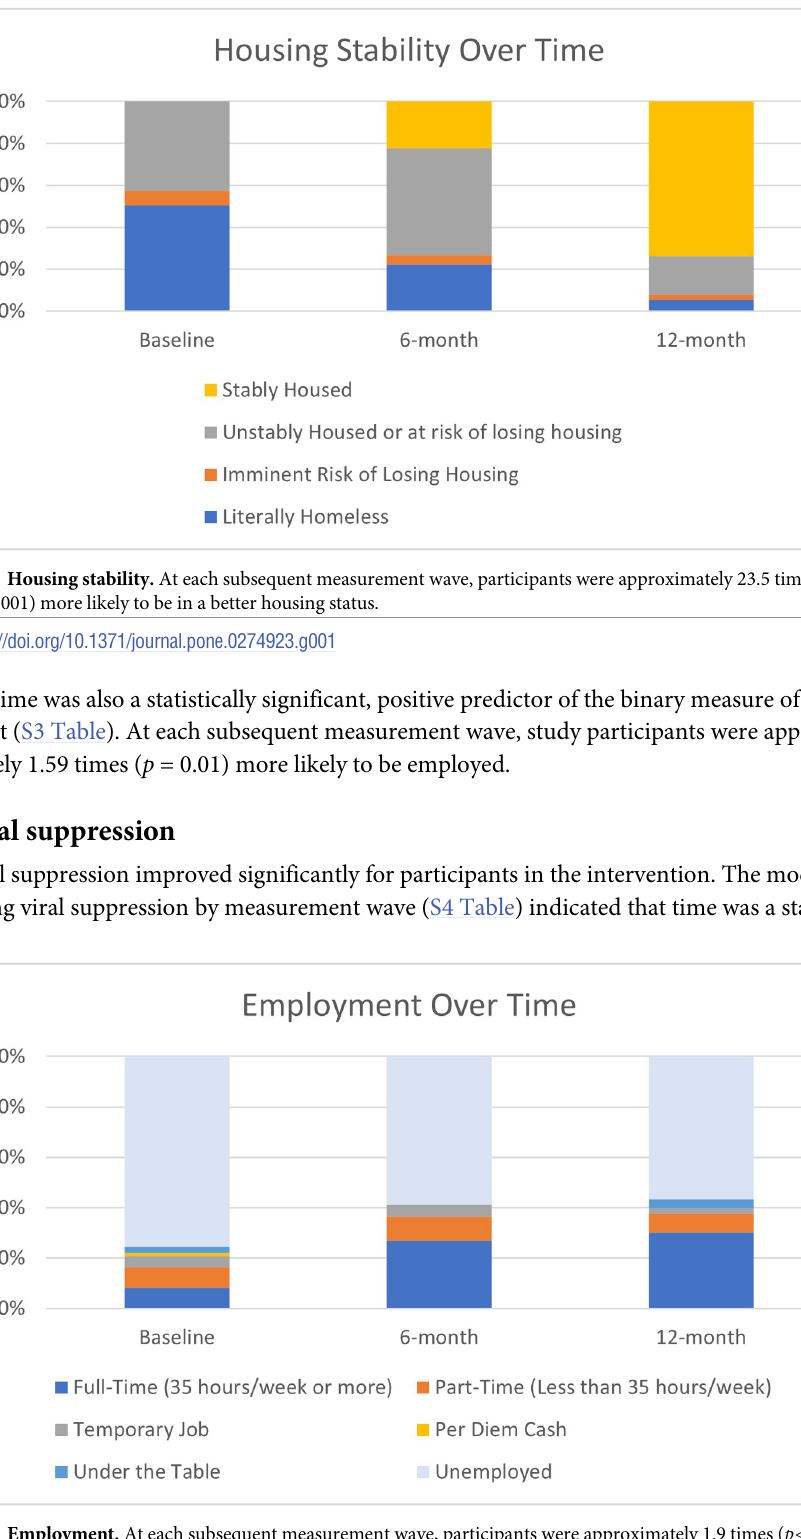
Fig 2. Employment. At each subsequent measurement wave, participants were approximately 1.9 times ( p < 0.001) more likely to be in a better employment